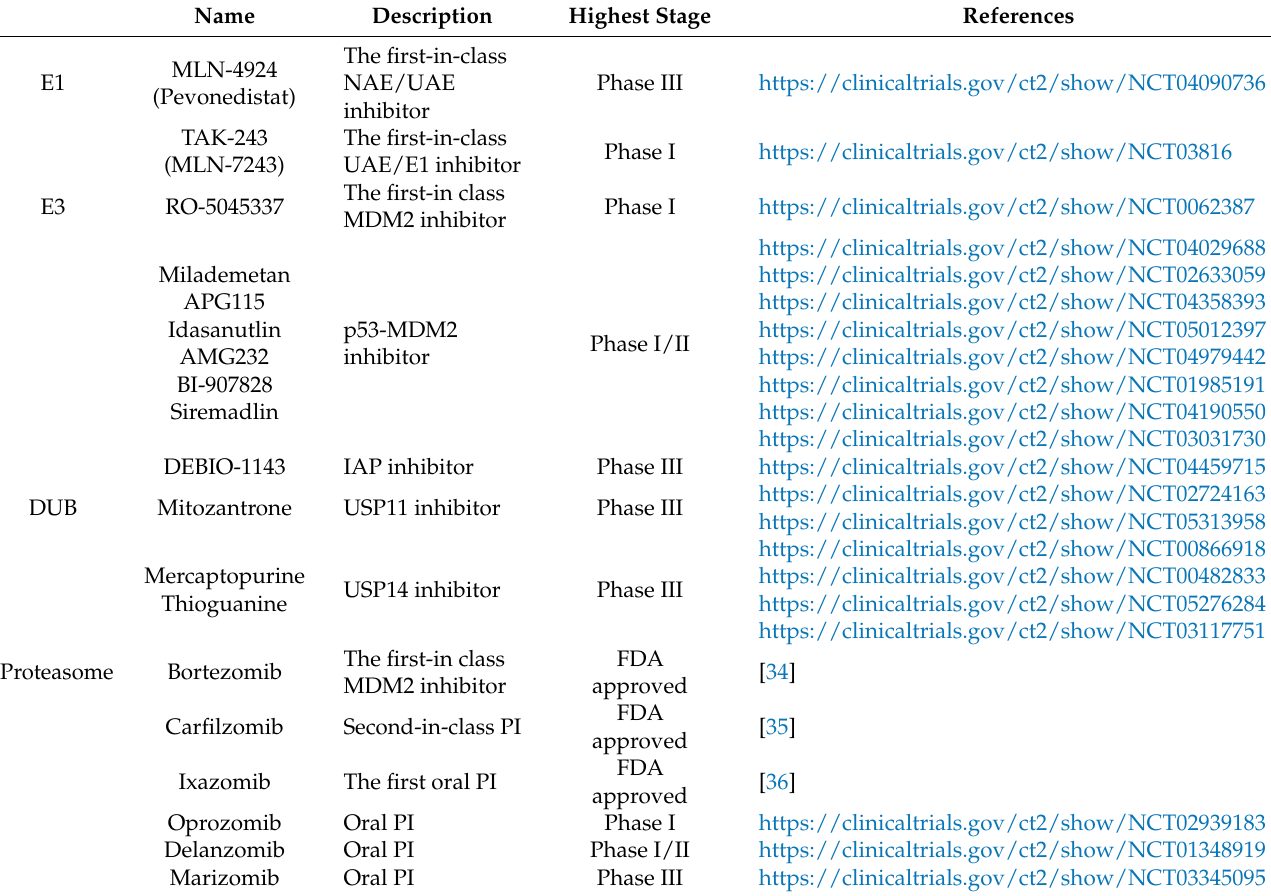
Table 2. List of anticancer drugs targeting UPS. Drugs under FDA/EMA approval or clinical investi- gation are summarized. For more detailed clinical information, see ClinicalTrials.gov. All accessed